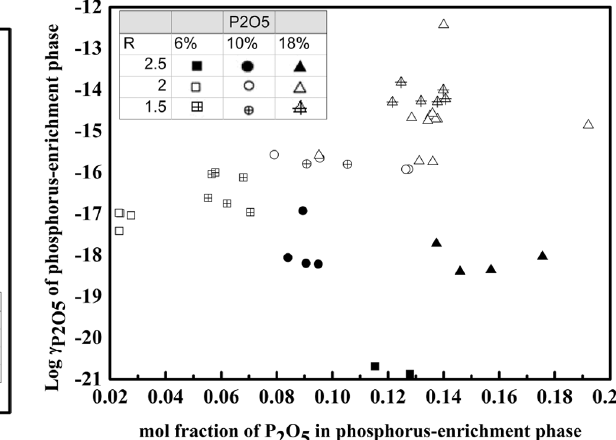
Fig. 10: The effect that content of T.Fe of matrix phase on the activity coefficient of P 2 O 5 of the CaO-SiO 2 -Fe t O-P 2 O 5 slag system